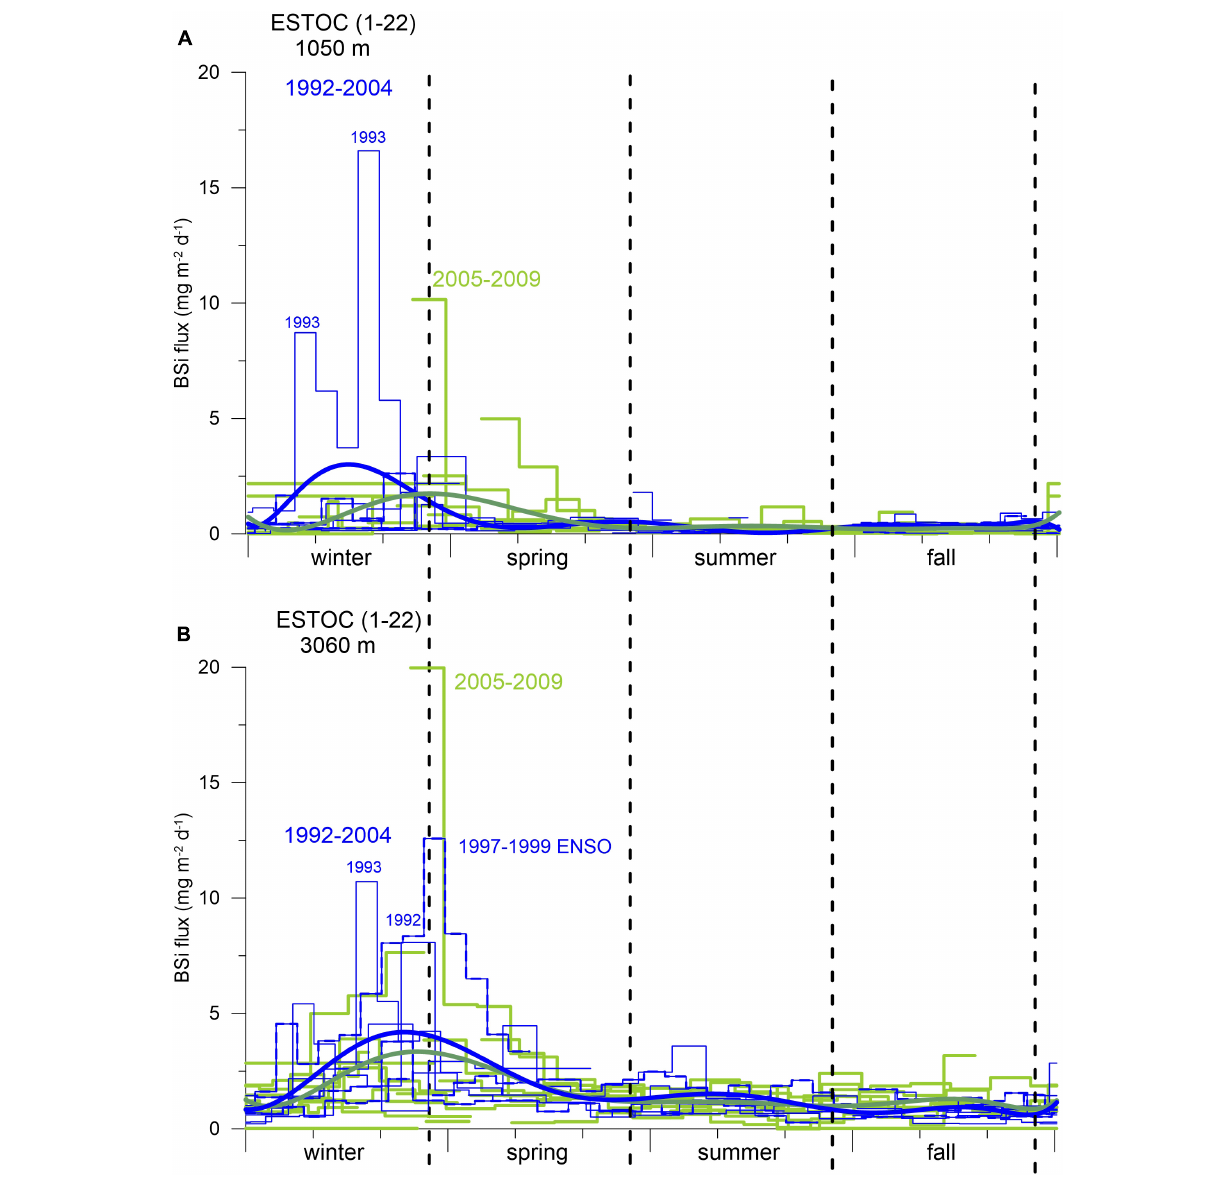
lateral advection with a slightly higher contribution in